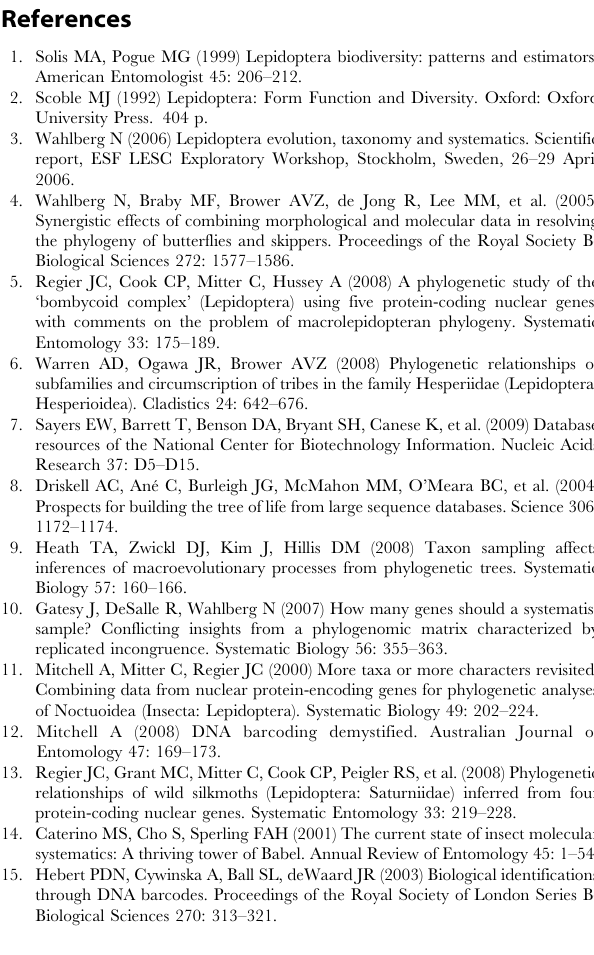
Table S1 Specimens used in practicality experiment.